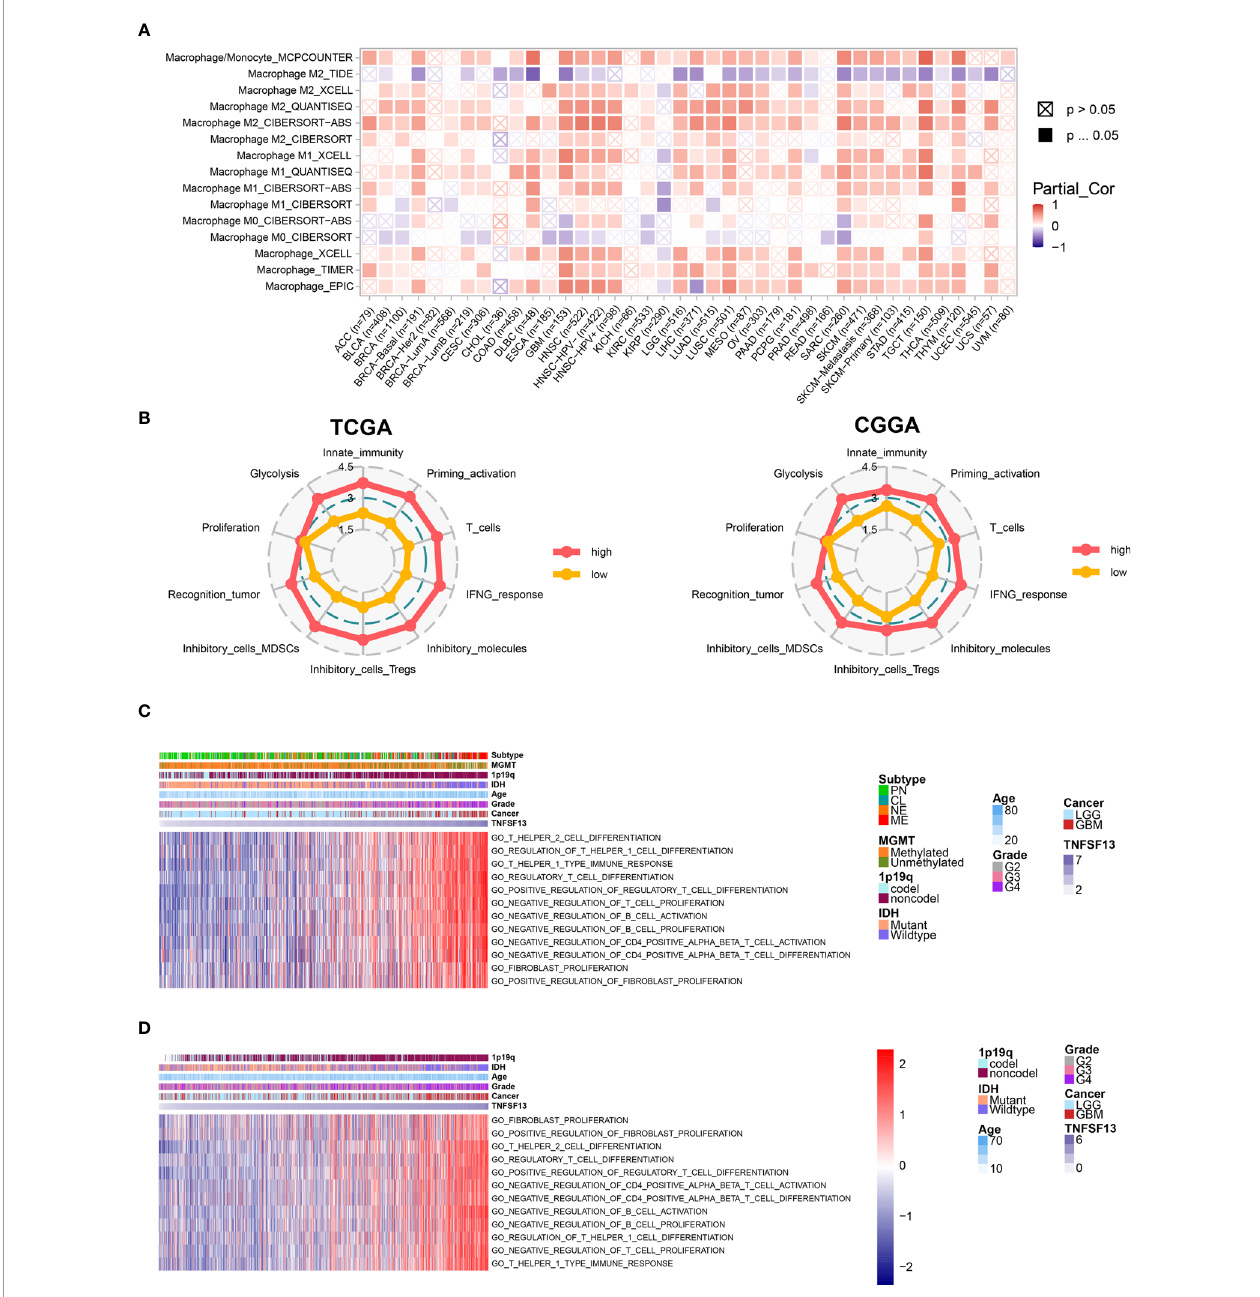
FIGURE 3 | Correlation between TNFSF13 and immunologic functions in gliomas. (A) Immune in fi ltration assessment for pan-cancer samples regarding macrophage based on TIMER 2.0. Red represents high expression of macrophage; purple represents low expression of macrophage. (B) Ten immunogram scores to analyze the correlation between TNFSF13 expression and tumor-in fi ltrating immune cells in gliomas from TCGA cohort and CGGA cohort. Red represents high TNFSF13 expression; yellow represents low TNFSF13 expression. The relationship between TNFSF13 and T cell immunity in pan-gliomas from (C) TCGA and (D) CGGA